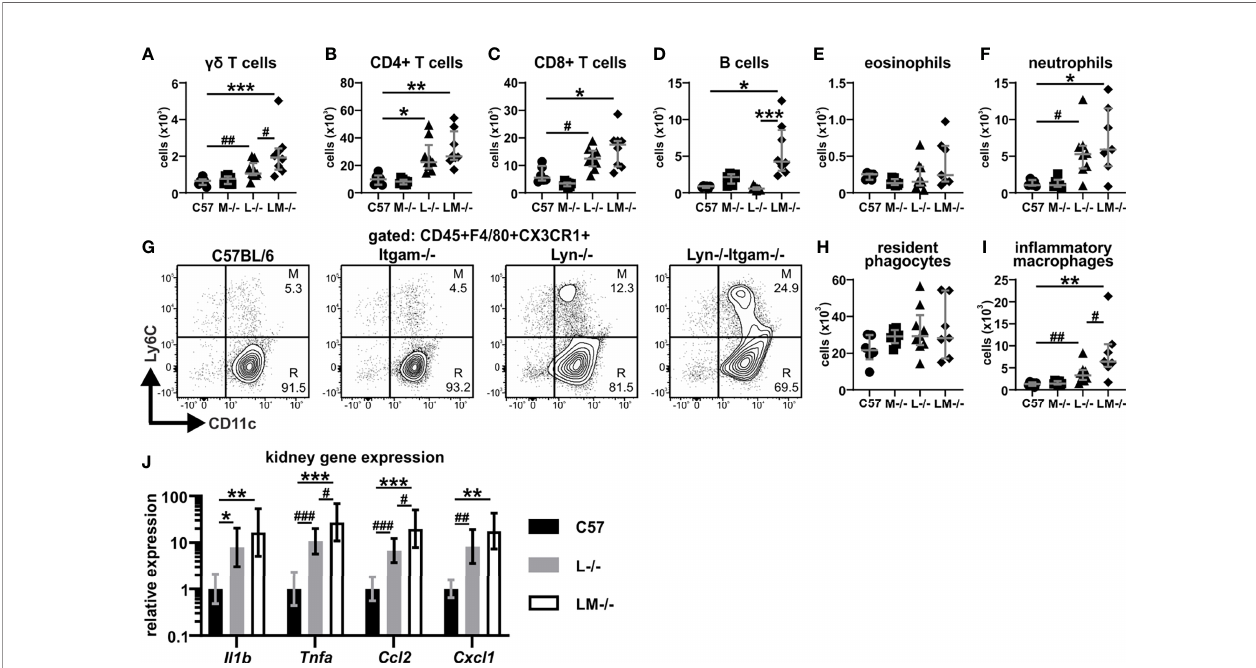
FIGURE 4 | Kidney in fl ammatory responses are enhanced by CD11b-de fi ciency in Lyn -/- mice. Perfused and digested kidneys of 24-week-old mice were assessed by fl ow cytometry for numbers of: (A) gd T cells, (B) CD4+ and (C) CD8+ T cells, (D) B cells, (E) eosinophils and (F) neutrophils; (G) populations of phagocytes gating on CD45+F4/80+CXCR3+ cells to delineate numbers of (H) resident macrophage-like phagocytes (CD11c+Ly6C-, R) and (I) in fl ammatory macrophages (CD11c+Ly6C+, M); (J) qRT-PCR gene expression of 24-week-old kidneys for Il1b , Tnfa , Ccl2 and Cxcl1 . For data in (A – F, H, I) , n = 5-9 per group, pooled from two experiments. Flow plots in (G) are representative of two experiments. Data in (J) are of n = 5-8 per group. *p < 0.05, **p < 0.01, ***p < 0.001 by Dunn ’ s multiple comparisons test and # p < 0.05, ## p < 0.01, ### p < 0.001 by Mann-Whitney U